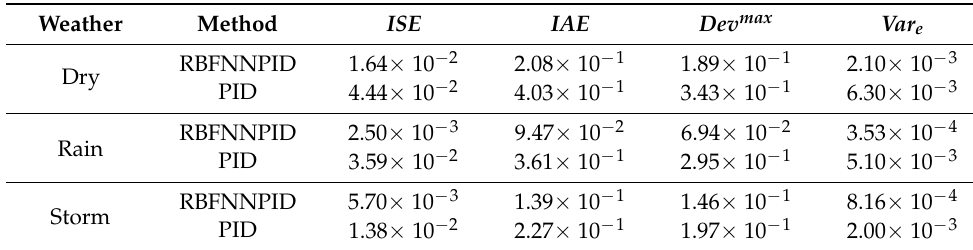
Table 1. Performance of two DO control methods.